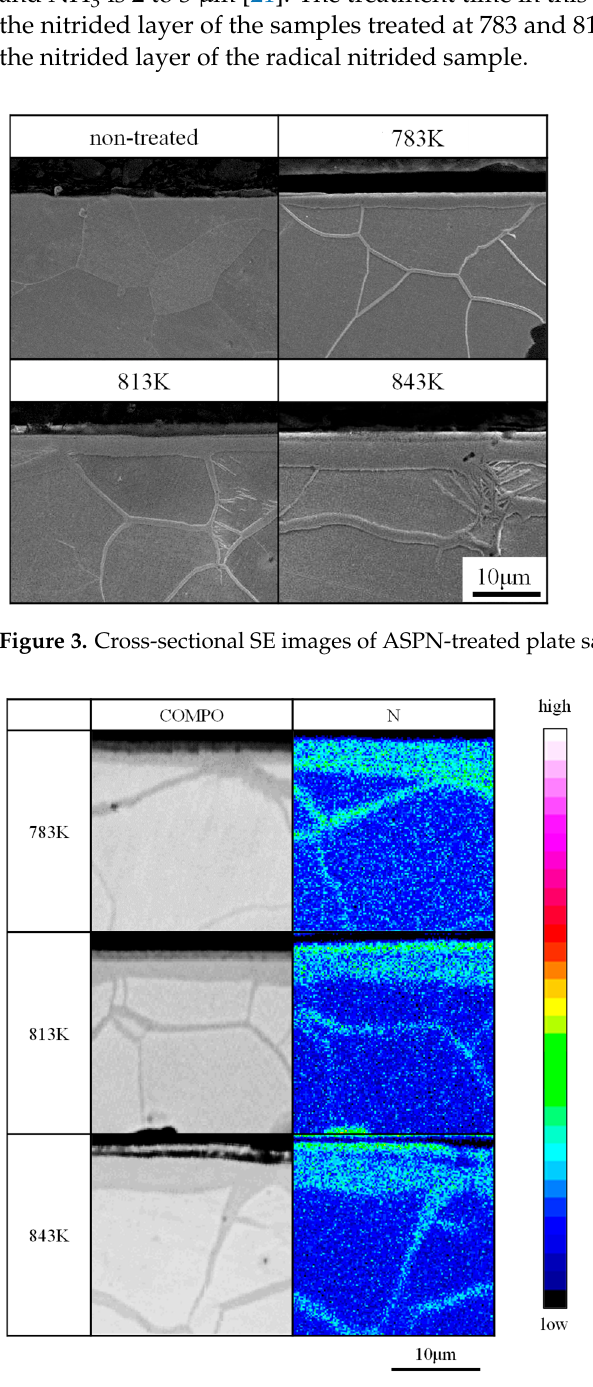
Figure 4. BSE images and nitrogen mapping images obtained by EPMA for ASPN-treated plate samples.